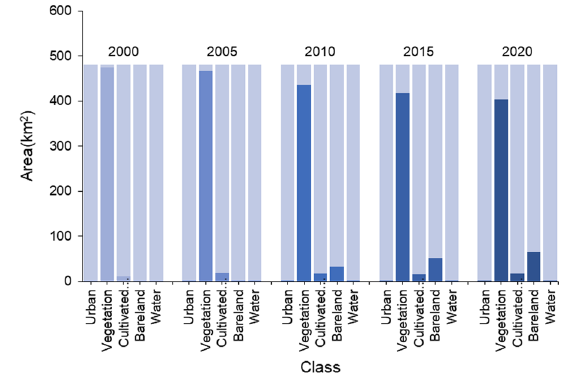
Fig. 3 Statistical data regarding LUCC classifications